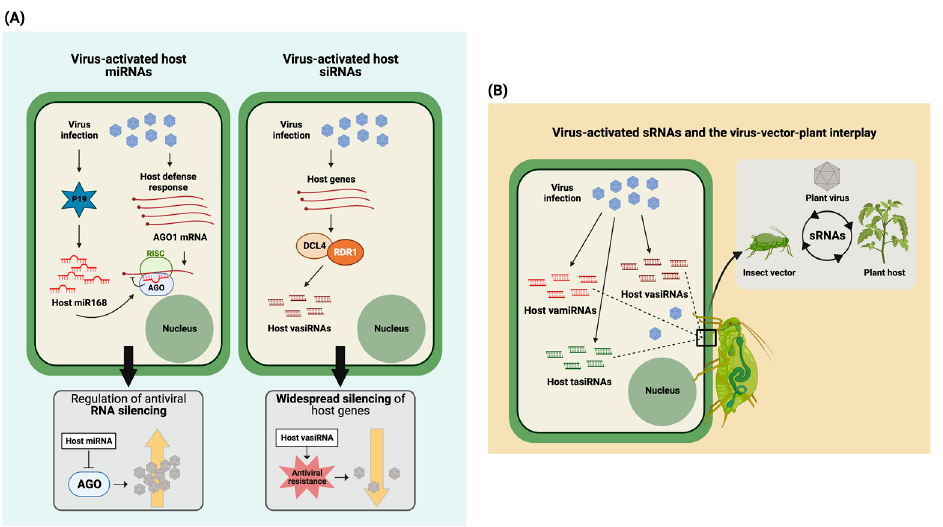
Figure 2. Implicated roles of virus-activated plant endogenous sRNAs in plant–virus interaction. In response to virus infection or activated by it, plants generate altered endogenous sRNAs profiles